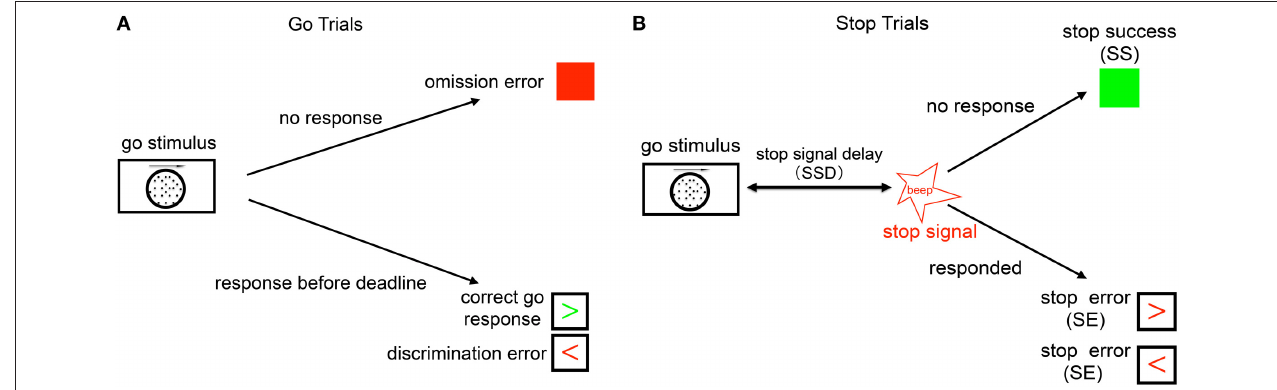
FIGURE 1 | Schematic illustration of the stop signal task. (A) Go trials: on go trials, subject is supposed to make a response to a default go response by pressing the left or right button, based on the coherent motion direction of random dots. The go reaction time (Go RT) is defined as the time the subject takes to respond from the onset of go stimulus. The subject makes a discrimination error if he/she chooses the wrong direction (wrong key), and an omission error if no response is recorded within the response deadline (1100 ms). (B) Stop trials: on a small fraction of trials, a stop signal appears after the go stimulus and instructs the subject to withhold the go response. The time delay between the go stimulus onset and the stop signal onset is called the stop-signal delay (SSD). If the subject makes a go response in a stop trial, this trial is considered a stop error (SE) trial, otherwise it is considered a stop success (SS)